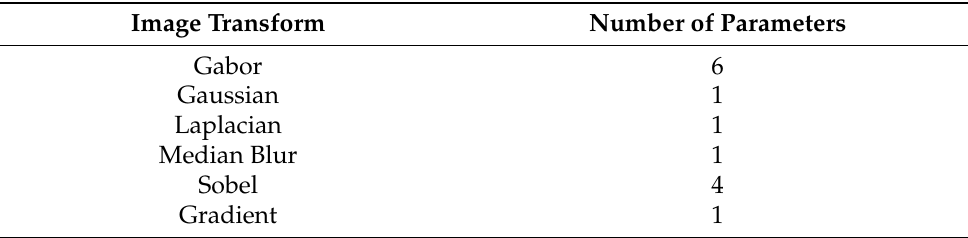
Table 1. Candidate image transforms and the number of